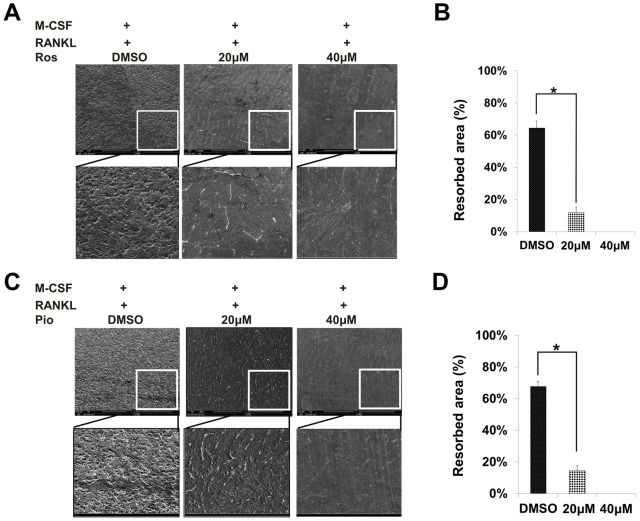
Rosiglitazone and pioglitazone significantly inhibit the formation of functional osteoclasts on bone slices.(A) BMMs were seeded on bone slices and treated with M-CSF (44 ng/ml) and RANKL (100 ng/ml) plus vehicle (DMSO), 20 µM or 40 µM of rosiglitazone (Ros) for 10 days. Bone resorption pits were visualized by SEM. One representative view from each condition is shown. (B) Quantification of resorbed bone area for Ros in A. Bars show percentage averages of resorbed bone area ±S.D. *P<0.05. (C) The same assays in A were carried out with pioglitazone (Pio). (D) Quantification of resorbed bone area for Pio in C. Bars show percentage averages of resorbed bone area ±S.D. *P<0.05.